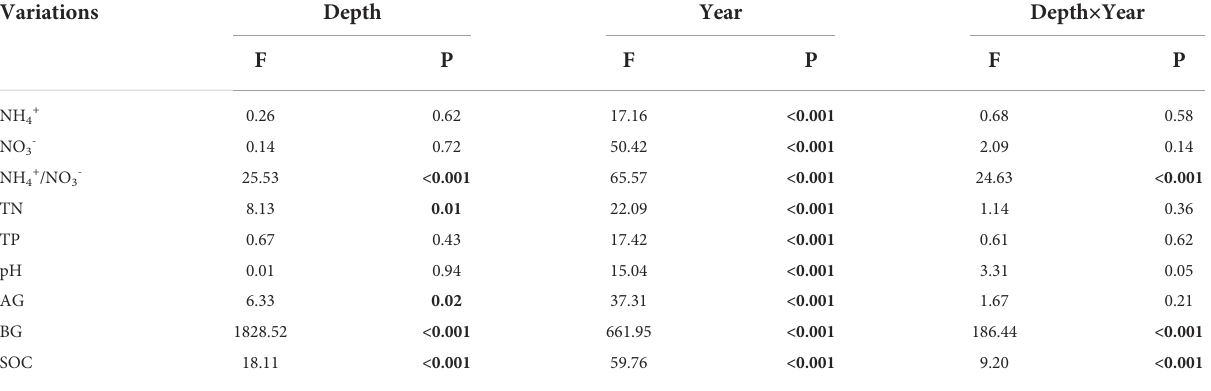
TABLE 1 Effects of soil depth (Depth) and cropping year (Year) on soil ammonium-nitrogen content (NH 4+ ), nitrate-nitrogen content (NO 3- ), the ratio of NH 4+ to NO 3- (NH 4+ /NO 3- ), total nitrogen content (TN), total phosphorus content (TP), pH, two C-acquiring enzymes: a - (AG) and b - glucosidase (BG), and soil organic carbon content